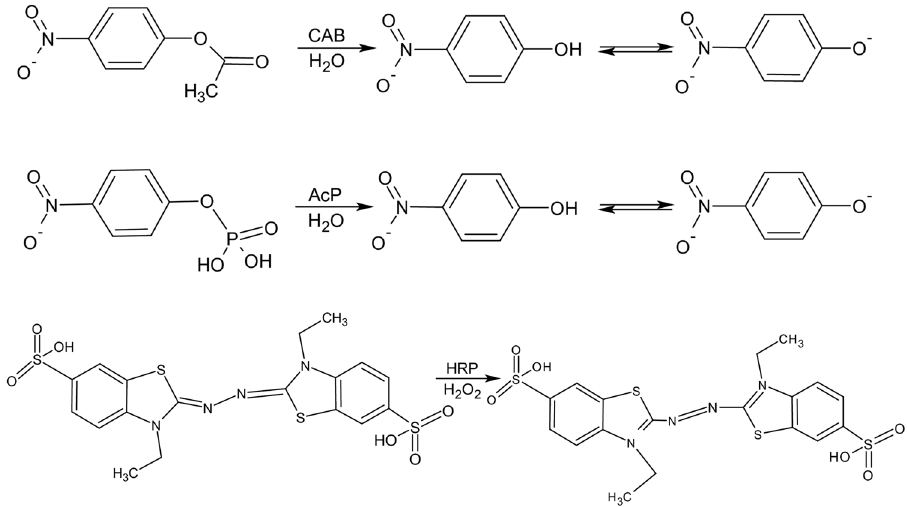
Figure 7. The enzyme-catalyzed reactions used in this